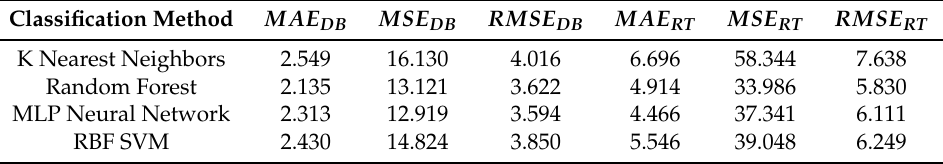
Table 1. Error calculation of database and real-time scanned data.